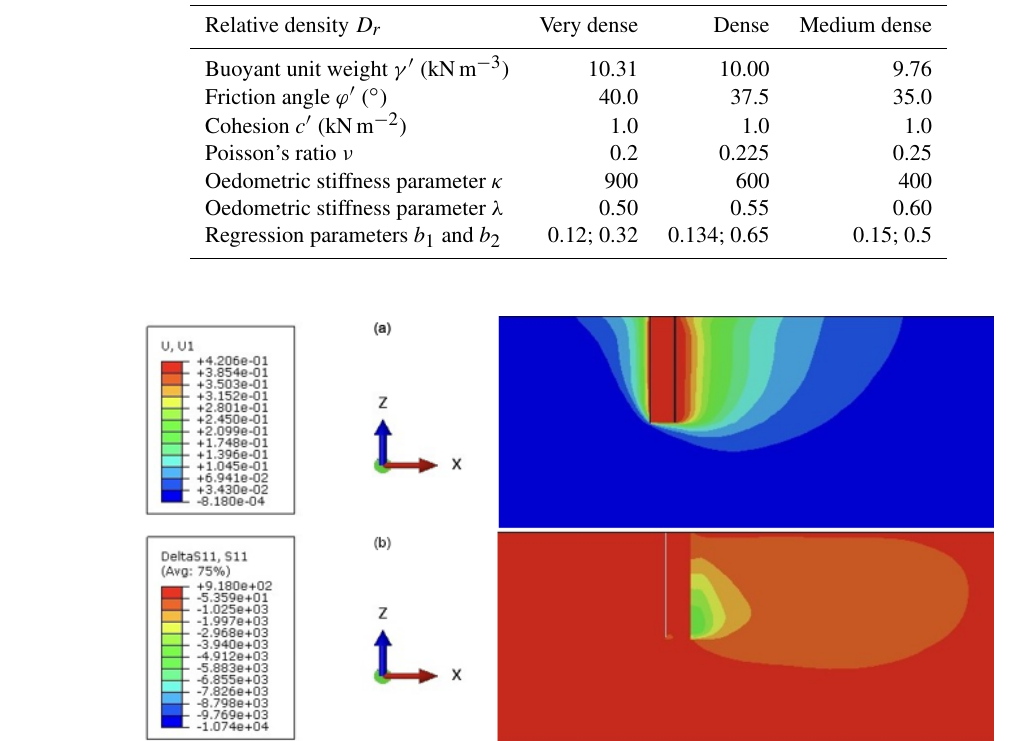
Wind Energ. Sci., 8, 327–339,